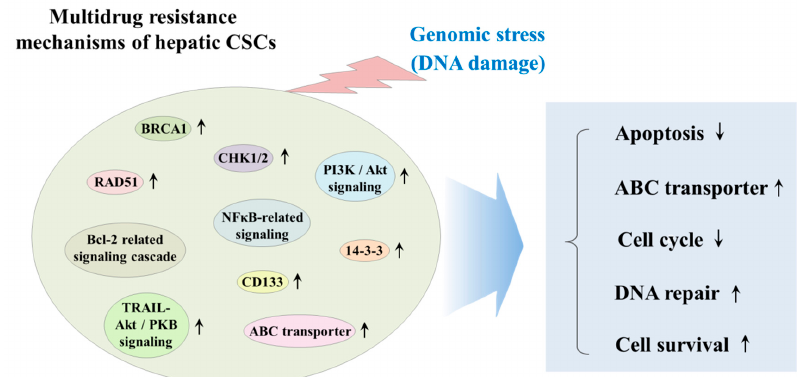
Figure 2. Schematic diagram summarizing the multidrug resistance mechanisms of hepatic